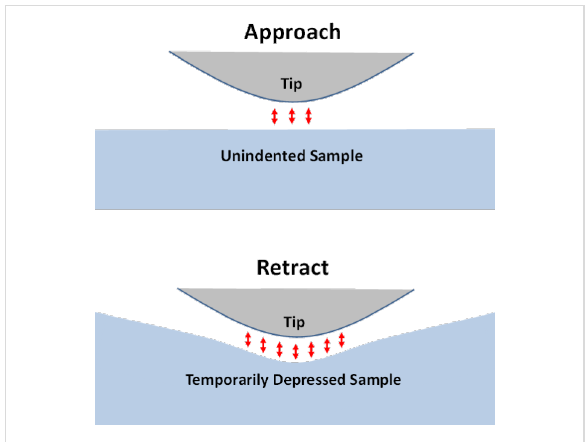
Figure 3: Illustration of tip–sample physical adhesion. In this case the interaction area between tip and sample is greater during the retract than during the approach, due to a change in the non-bonded attrac- tive forces, leading to additional dissipation as the cantilever breaks free from the